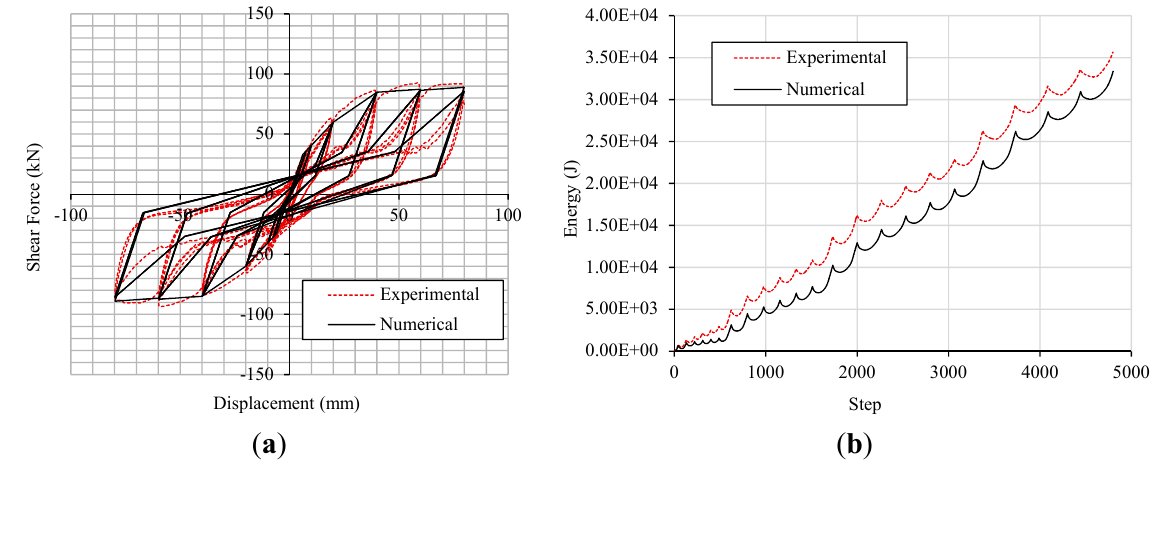
Figure 17. Wall A: ( a ) Hysteresis loops; ( b ) Dissipated